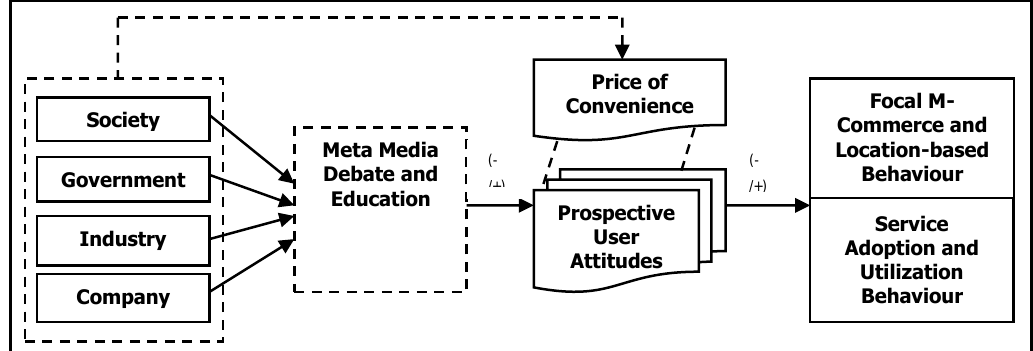
Figure 1: The PoC Model (Ng-Kruelle et al .,